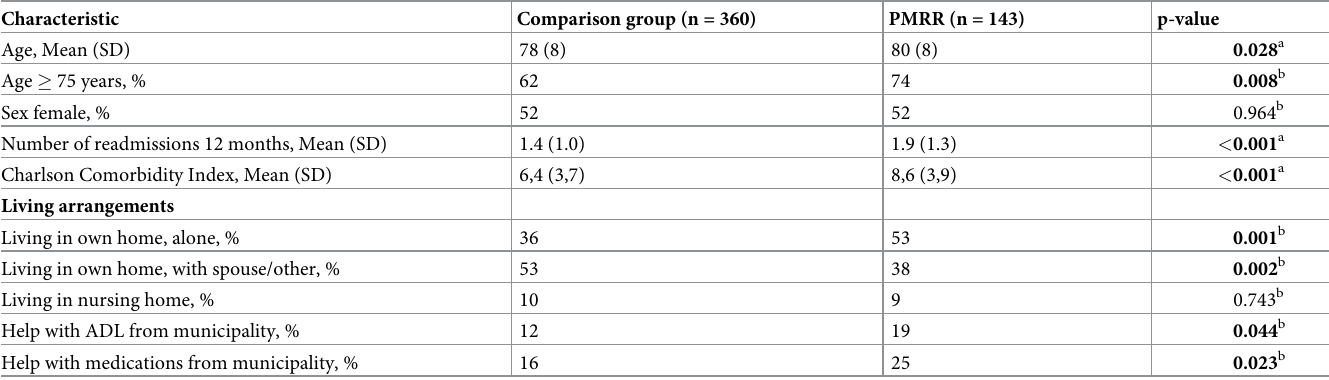
Table 1. Patient characteristics prior to initial